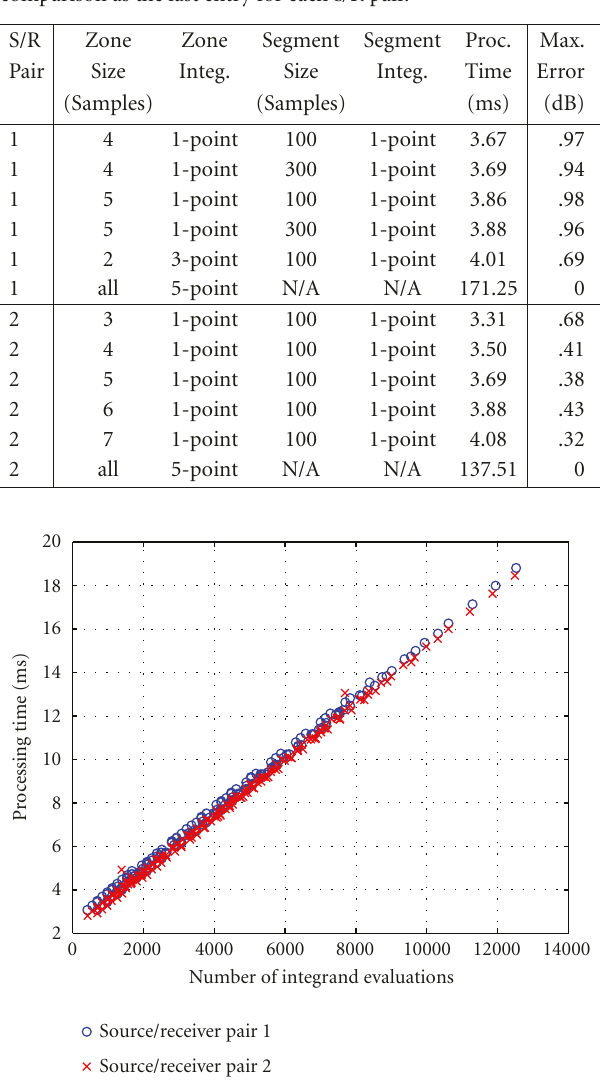
Table 1: Parameters resulting in the 5 fastest processing times for each S/R pair with maximum error in the smoothed spectrum less than 1 dB. Data for the baseline calculations are also included for comparison as the last entry for each S/R pair.